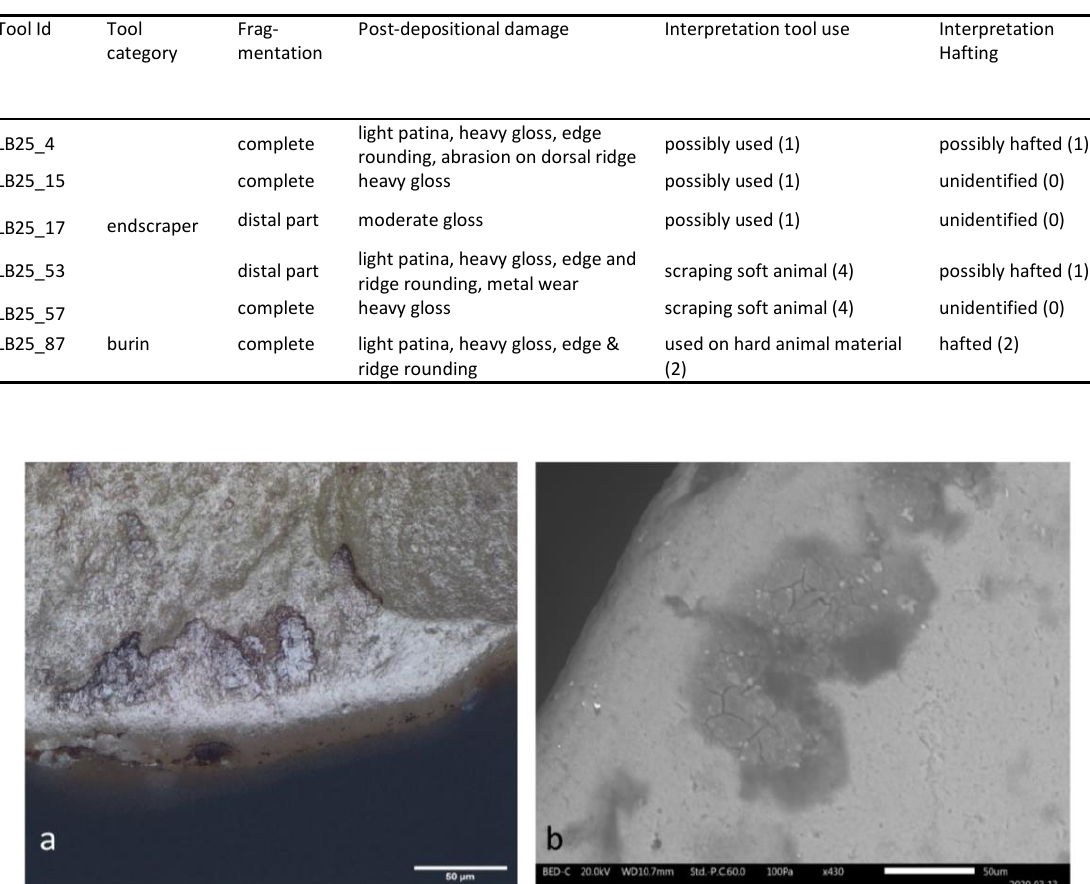
Table 6. Overview of the six tools from locus LB25 with use-wear evidence (scale of certainty related to the interpretation: uncertain (0) poor certainty (1); moderate certainty (2); high certainty (3); certain